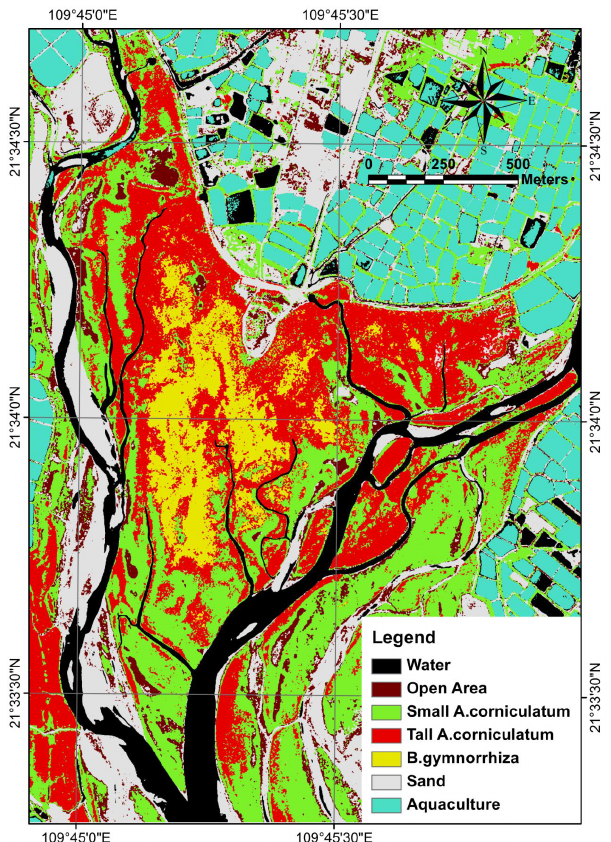
Fig. 4. Land-use/cover supervised classification of Gaoqiao based Figure 4. Land-use/cover supervised classification of Gaoqiao based on the pansharpened 3 on the pansharpened multispectral GeoEye-1 (2009) image, and the multispectral GeoEye-1 (2009) image, and the fieldwork transects shown in figure 1. 4 fieldwork transects shown in Fig.